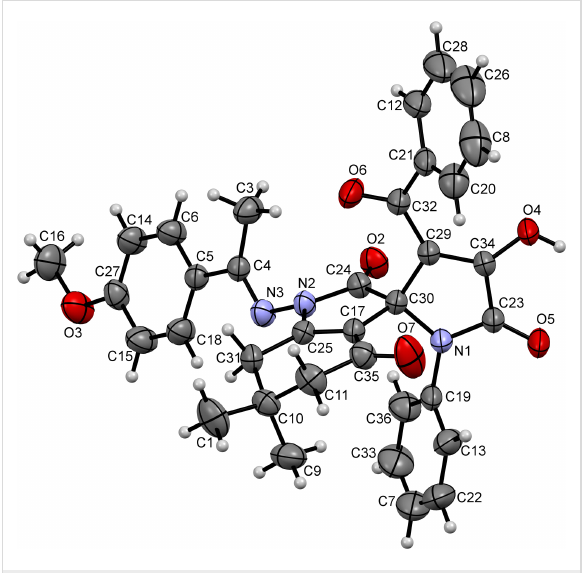
Figure 2: ORTEP drawing of compound 21ab (CCDC 1546063) showing 50% probability amplitude displacement ellipsoids.